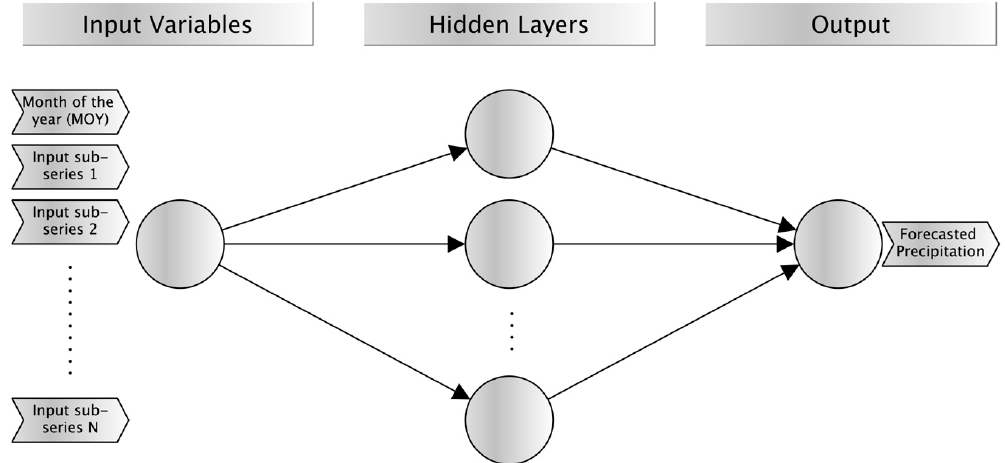
Figure 3. Multilayer Perceptron Neural Network architecture used in this work.